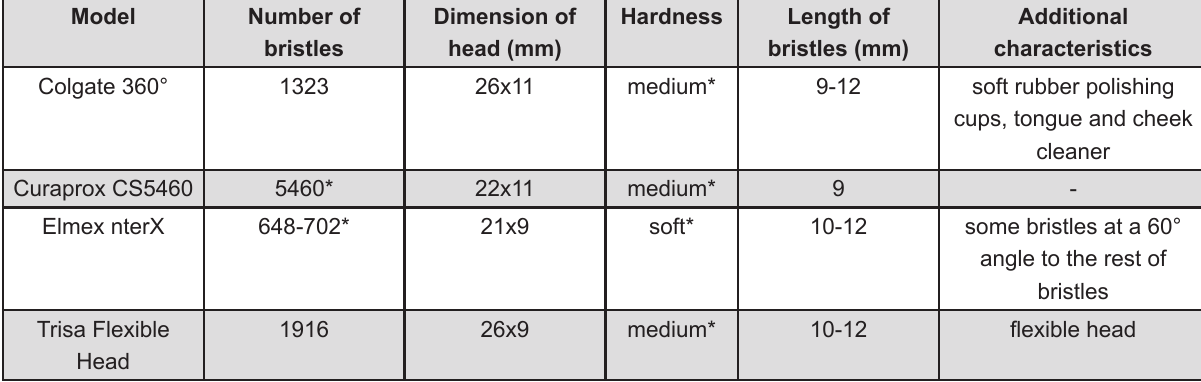
Figure 1- Characteristics of the toothbrushes used in the